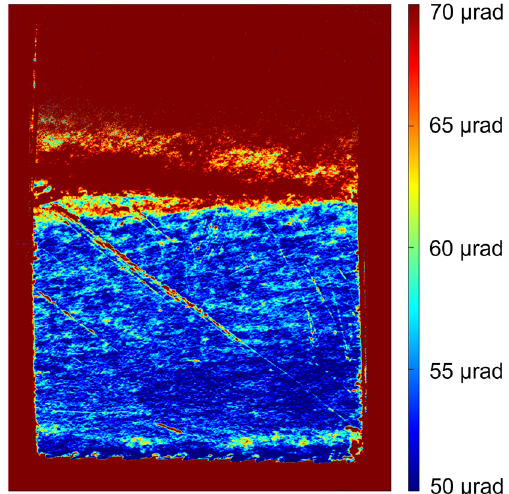
Fig. 3 Imaging of the sample mosaicity measured at BM05 beamline ofESRF(Grenoble,France).Colorindicatesthemosaicityofthesample